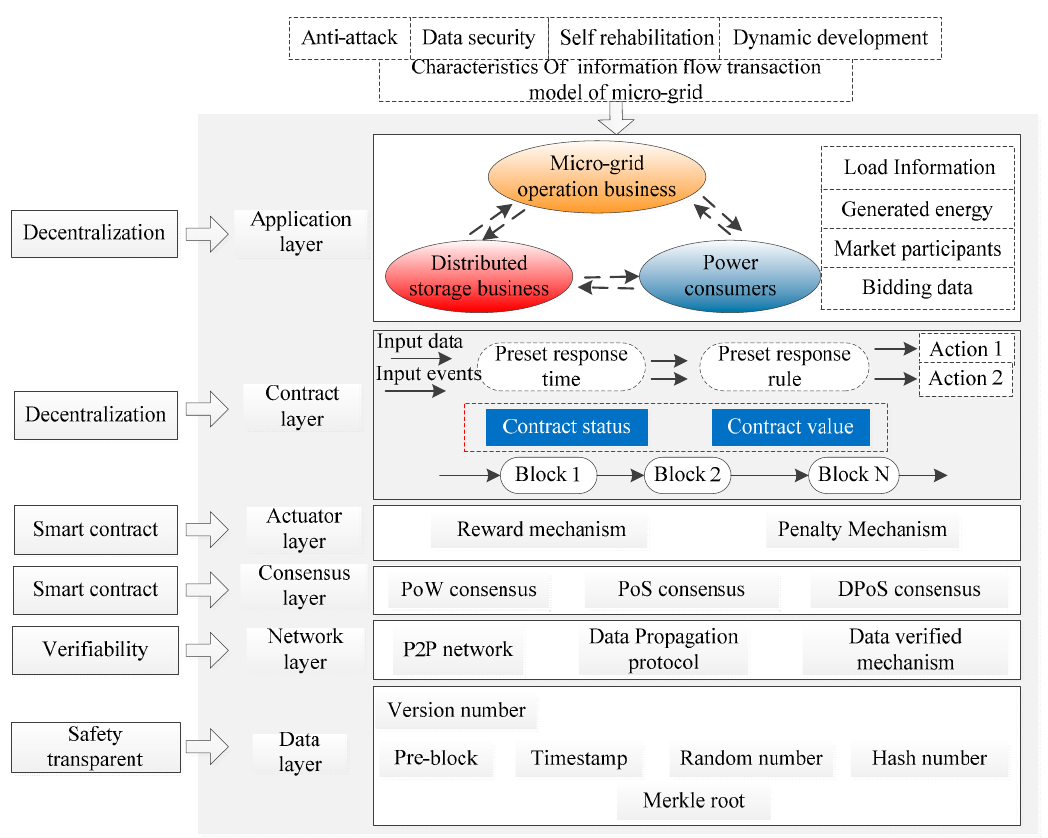
Figure 5. Information flow trading model.